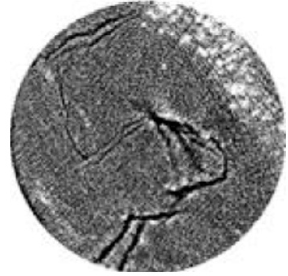
Figure 1. Fracture development under ultrasonic vibration excitation.